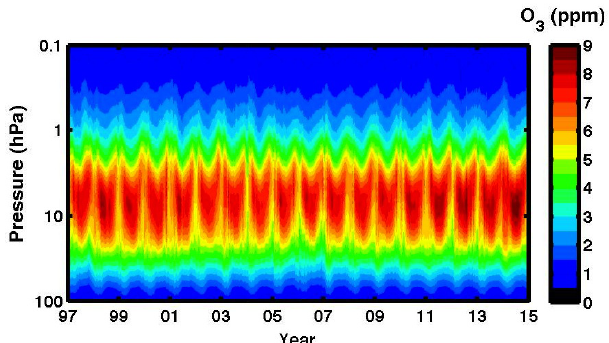
Figure 5. Harmonised time series of stratospheric ozone VMR pro- files recorded by GROMOS from January 1997 to January 2015 above Bern,